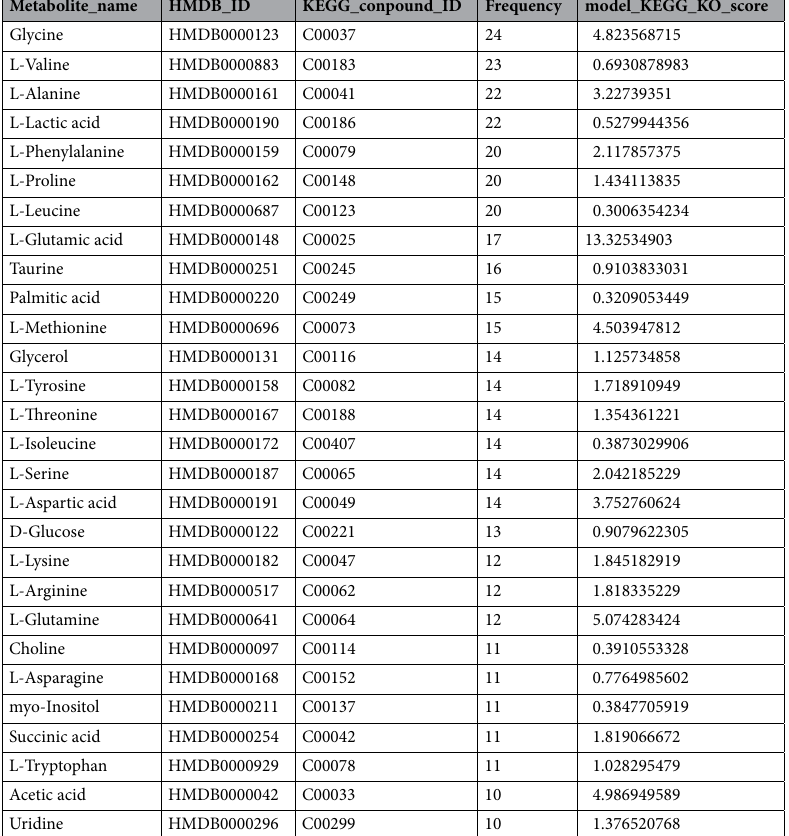
Table 4. Metabolites described as systematically deregulated in cancer and their relevance in the model using KEGG functional features. HMBD is the identifier of the metabolome database (https:// hmdb. ca/) and the Frequency column denotes the number of studies in which the metabolite was found as deregulated according to a recent review 53 . The metabolite scores were calculated by adding the KEGG_KO’s scores, from the machine learning model, for each of the